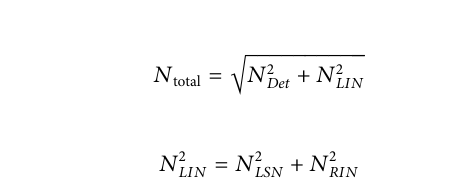
FIGURE6| Rawheterodynesignalsat5.3 Hz( redcurve )and8 Hz( blue curve ) modulation frequencies, LO wavelength as a function of the injection current.